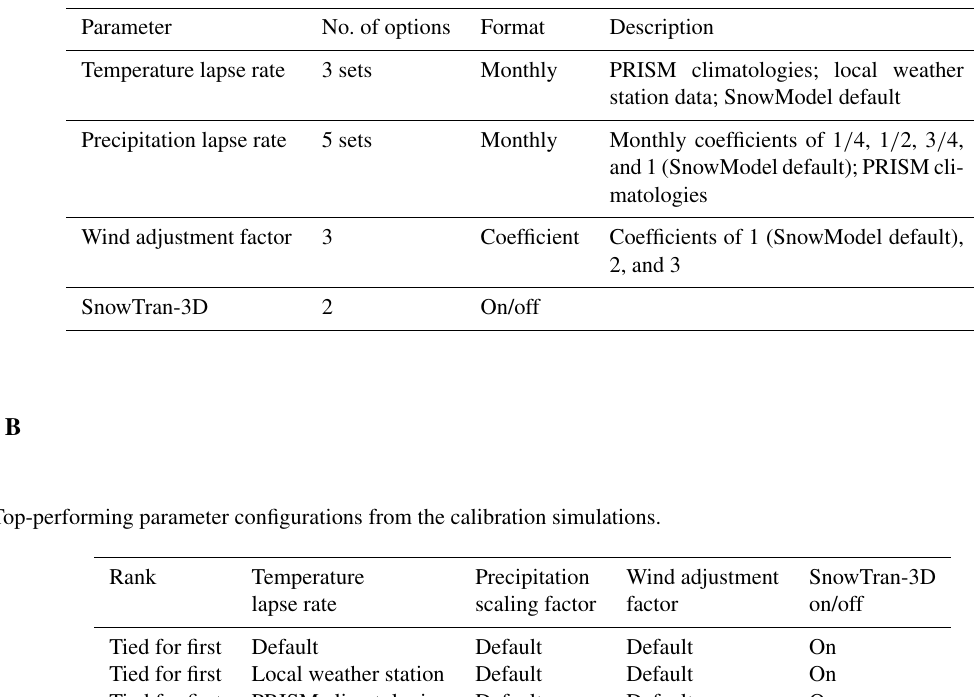
Table A1. Model calibration parameters and their descriptions.